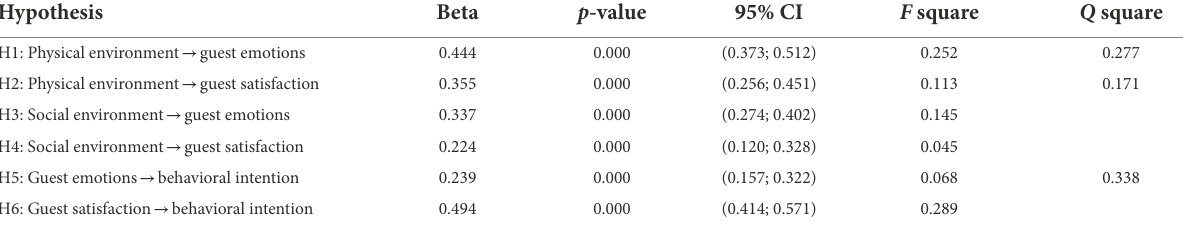
TABLE 7 : Results of path